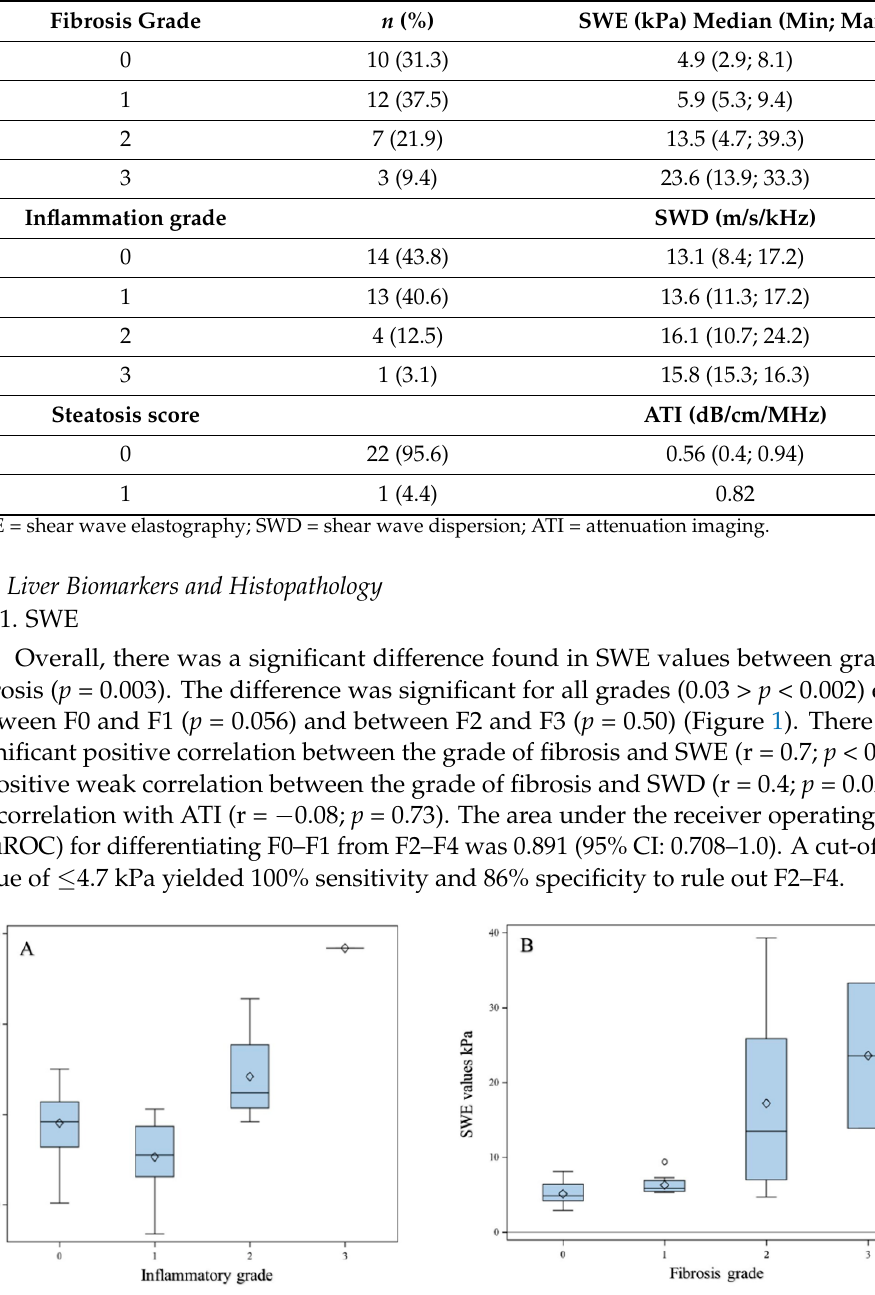
Figure 1. Box and whisker plot diagram for SWD ( A ) and SWE ( B ) relative to inflammation grade and fibrosis grade.